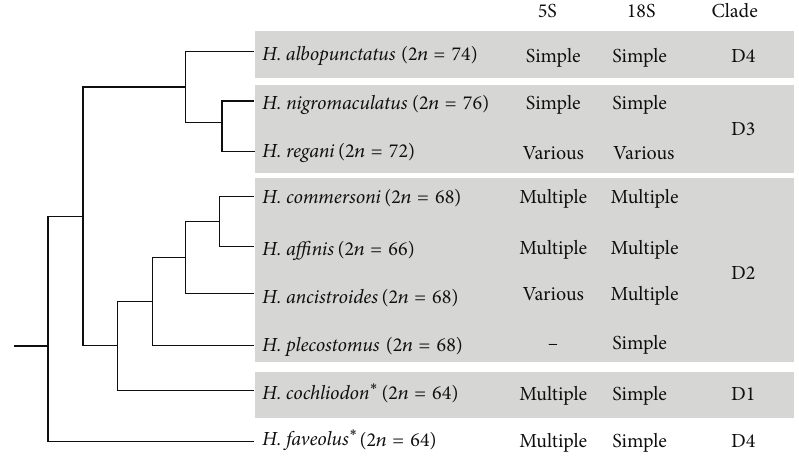
Figure 4: Data on rDNAsites number plotted against the phylogenetic relationship between species. Thecladogram is only representative and is based on the phylogeny proposed by Montoya-Burgos (2003), with addition of species marked with an asterisk. “Clades” refer to the clades proposed by the same author. Hypostomus cochliodon is added considering information from Armbruster [1] and H. faveolus considering information from Martinez